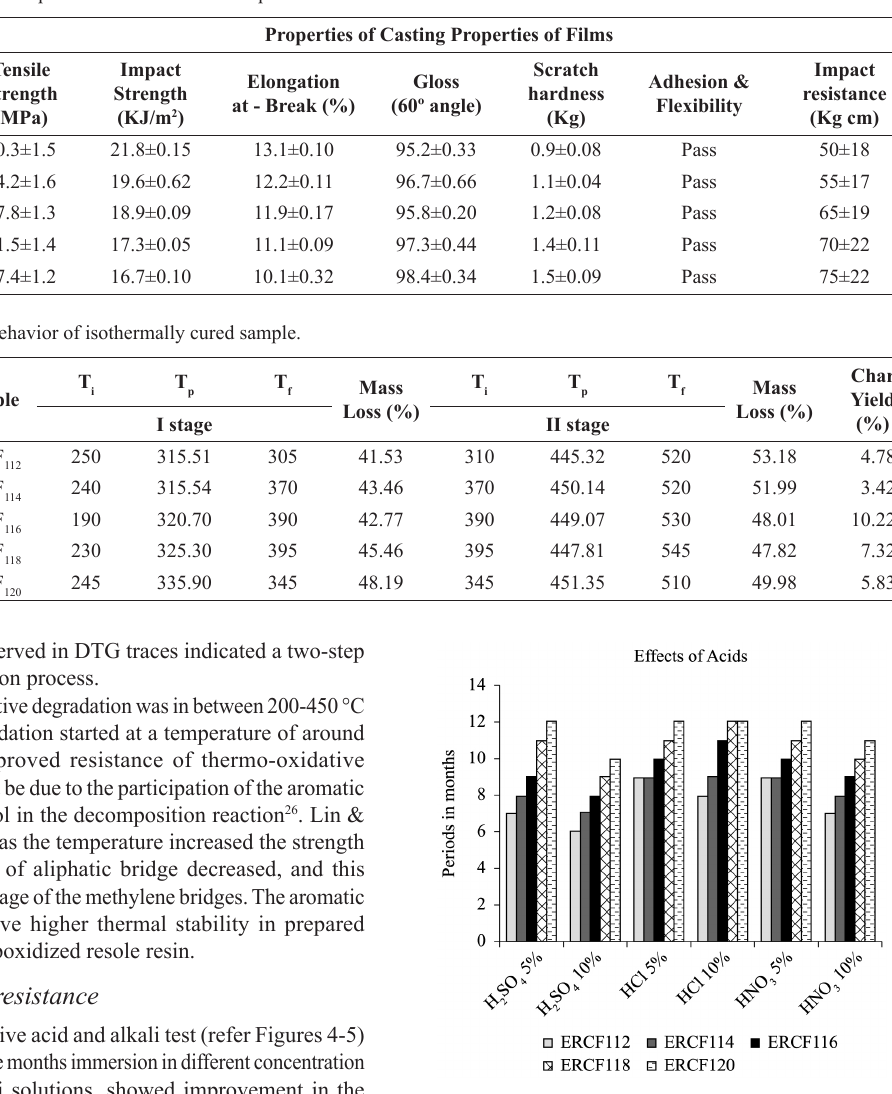
Table 2. Mechanical Properties of cardanol- based epoxidized resole resin.